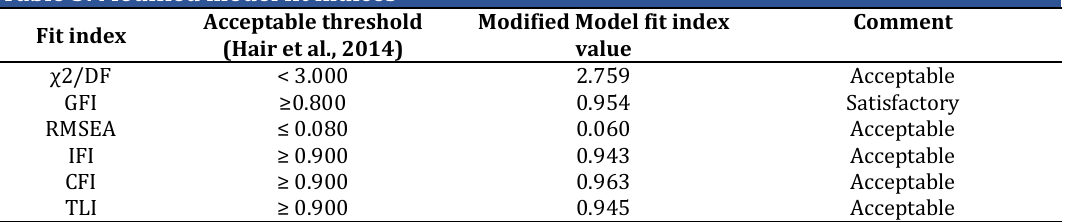
Table 3: Modified model fit